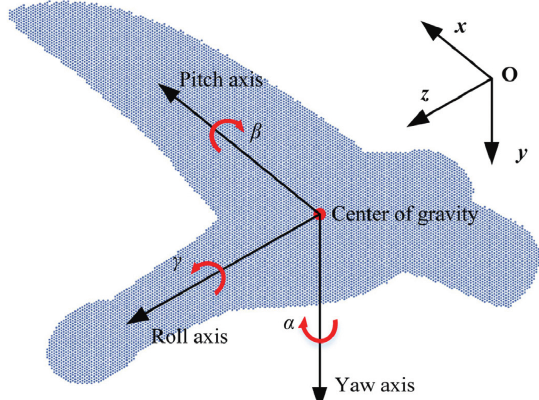
Figure 5: Definition of the Tait–Bryan angles.